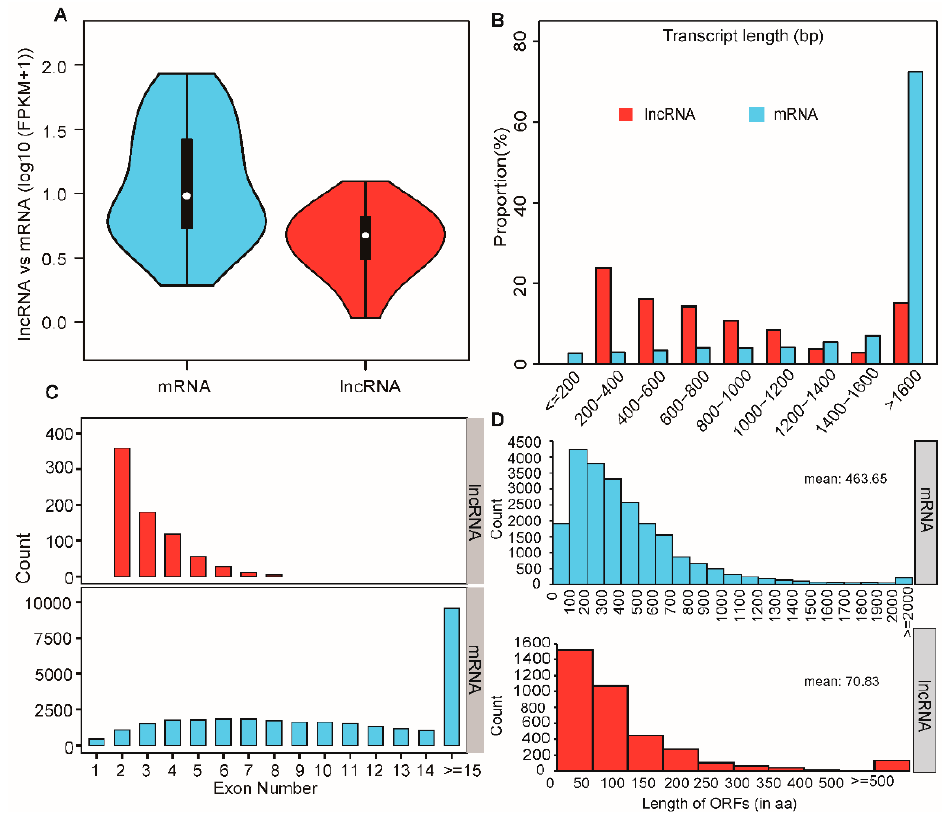
Figure 5. Comparison of genomic features of mRNAs and lncRNAs. ( A ) Expression levels of total mRNAs and lncRNAs using log 10 (FPKM + 1). ( B ) The transcript length of mRNAs and lncRNAs. The x axis represents the length of transcripts, and the y axis represents the composing proportion. ( C ) Distribution of exon numbers of mRNAs and lncRNAs. ( D ) Distribution of open reading frames (ORFs) lengths in mRNAs and lncRNAs.